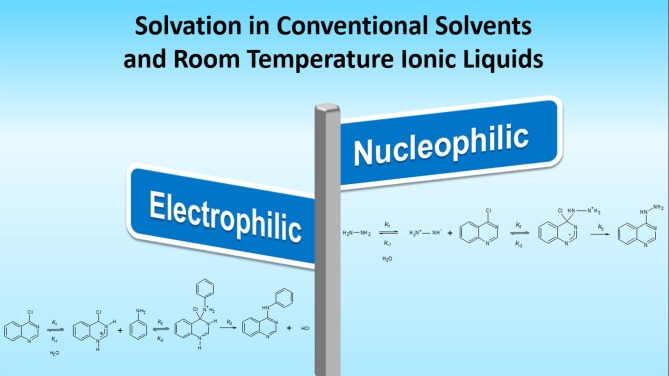
Graphical Abstract.